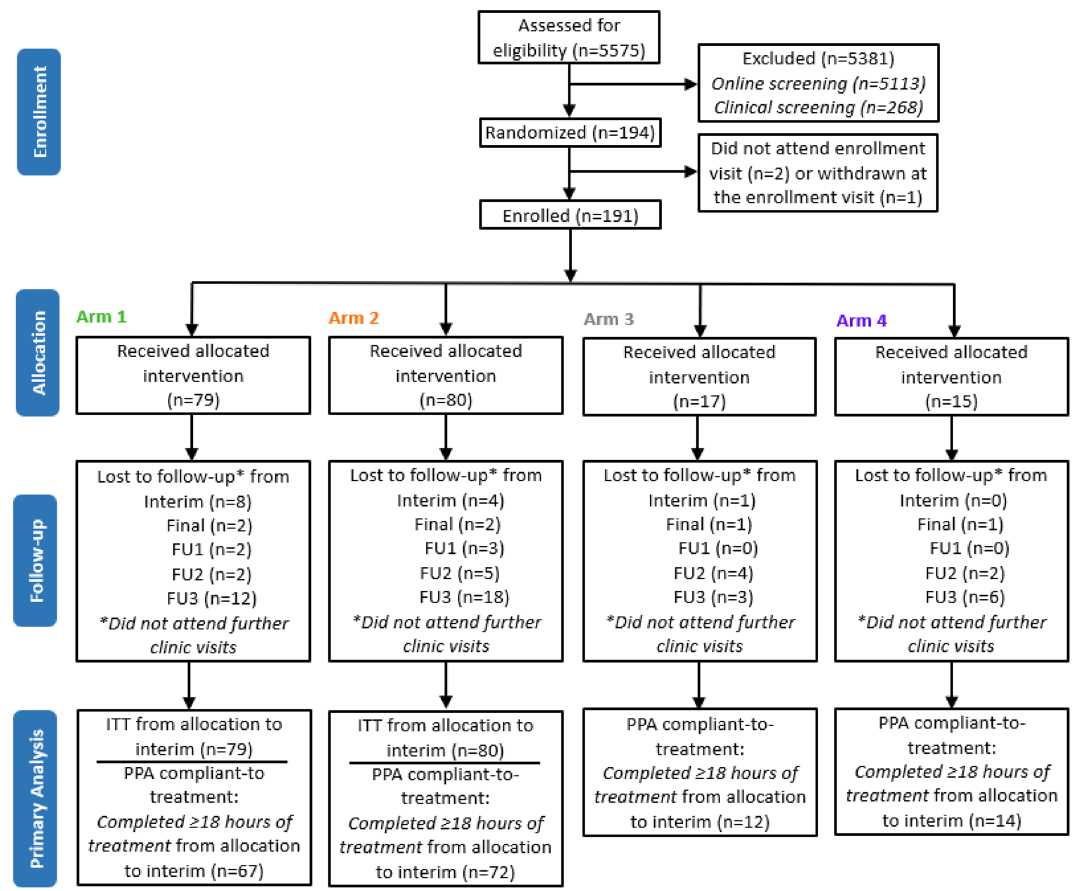
Figure 2. Participant flow diagram. For the primary endpoint analyses, within-arm comparisons from start of treatment to the 6-week assessment for THI and TFI were performed with per-protocol analysis (PPA) for those who were compliant to treatment (at least 18 h of device usage over 6 weeks of treatment period). Only arm 1 was included for the within-arm primary endpoint analyses whereas the other arms were included as additional analyses. Between-arm comparison was performed only between arm 1 and arm 2 for the primary endpoint analyses for changes in THI scores from start of treatment to the 6-week assessment using intention-to-treat (ITT) with imputation for missing values described in the Methods. Additional exploratory analyses for THI and TFI were performed at other time points during treatment and up to week 64 (12 months post-treatment) that are presented in this paper, with compliance and participant number information provided where appropriate for those analyses. Follow-up (FU) visits are depicted in Fig.